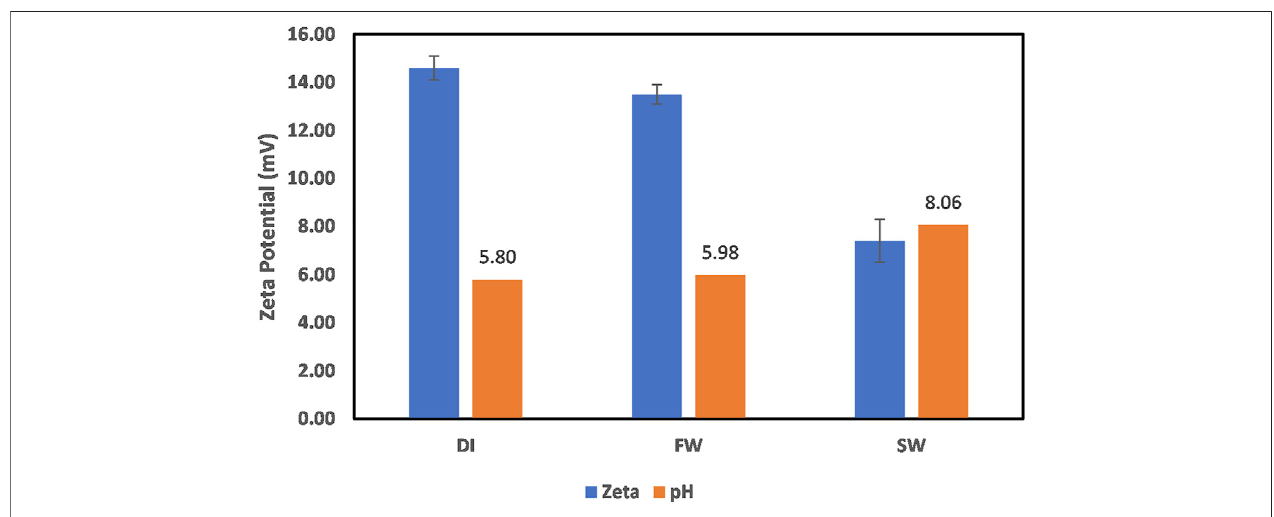
FIGURE 1 | Barite particle surface charge in DI, FW, and